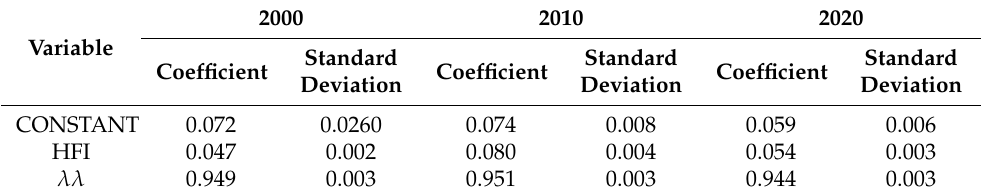
Table 10. Regression estimation of the spatial error